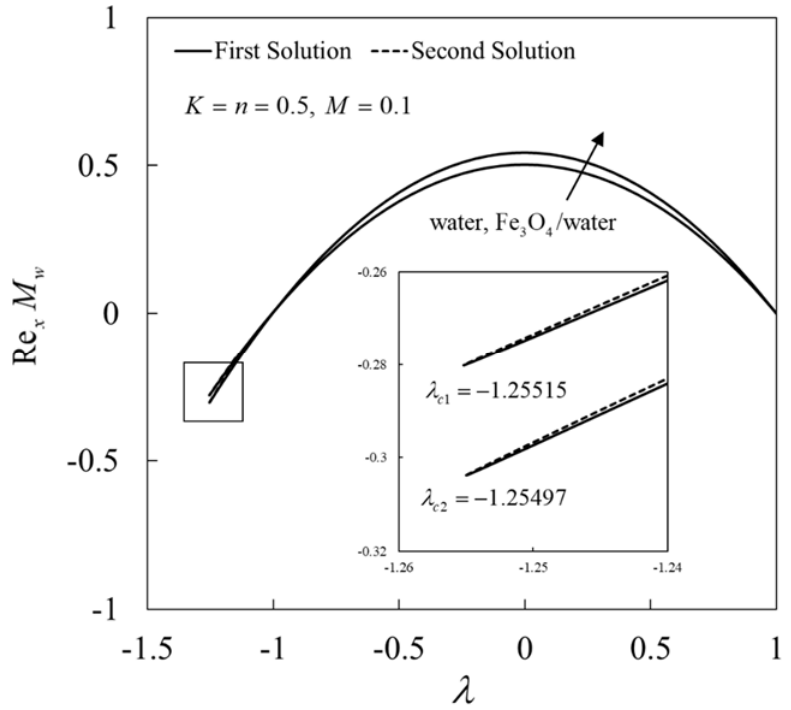
Figure 5. Re (cid:3051) 𝑀 (cid:3050) vs. 𝜆 for water and Fe 3 O 4 /water.